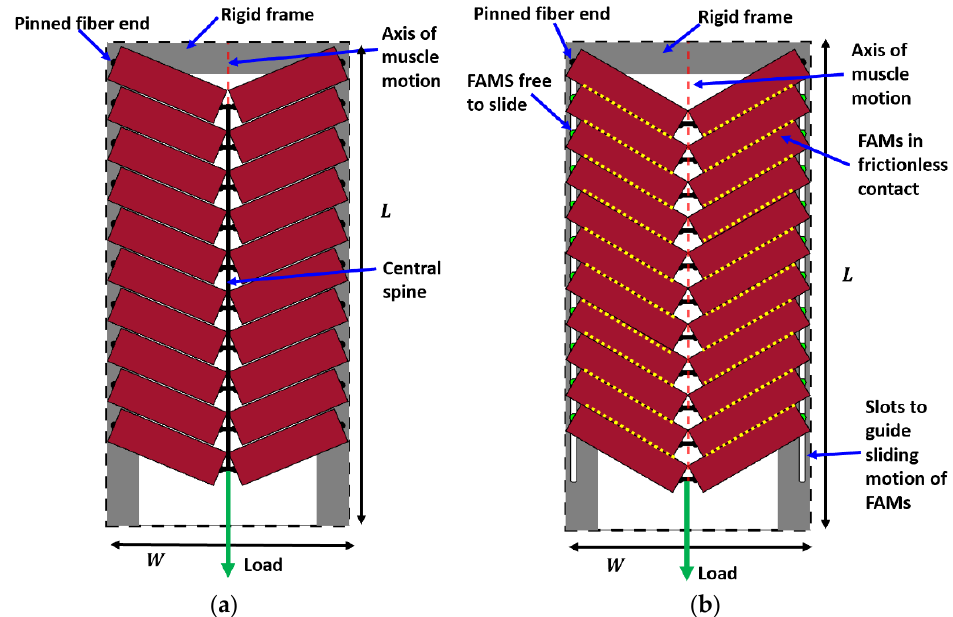
Figure 2. Two-dimensional visual representation of ( a ) pinned boundary condition and ( b ) fiber contact boundary condition of a bipennate muscle. The length and width of the bounding envelope are illustrated. The muscle is shown in planar view so that the depth dimension 𝐷 is not indicated. The bounding envelope is indicated by the black dashed lines around the rigid frame. The red, dashed vertical line represents the axis of muscle motion, and the green arrow indicates the applied load. The black semicircles indicate the pinned fiber end locations on the rigid frame and central carriage. The green semicircles indicate the fiber ends to translate vertically along the rigid frame and central carriage. Symmetrical slots on the frame and central carriage in ( b ) are shown to direct the vertical translation of the FAMs. Yellow dotted lines in ( a ) indicate FAM surfaces in frictionless contact.